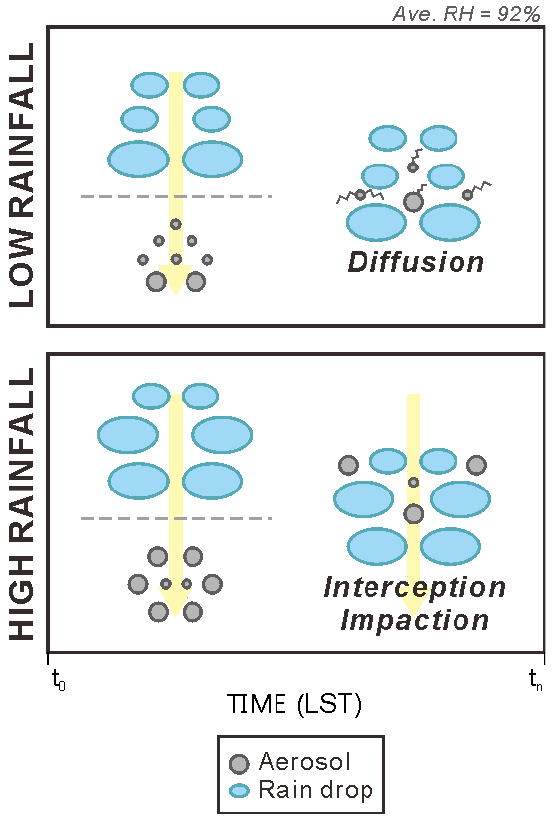
Figure 10. Schematic diagram of relationship between aerosol and raindrop particles. The gray and blue circles indicate aerosol and raindrop particles, respectively. Droplet number and size indicate the number concentration and drop size, respectively.